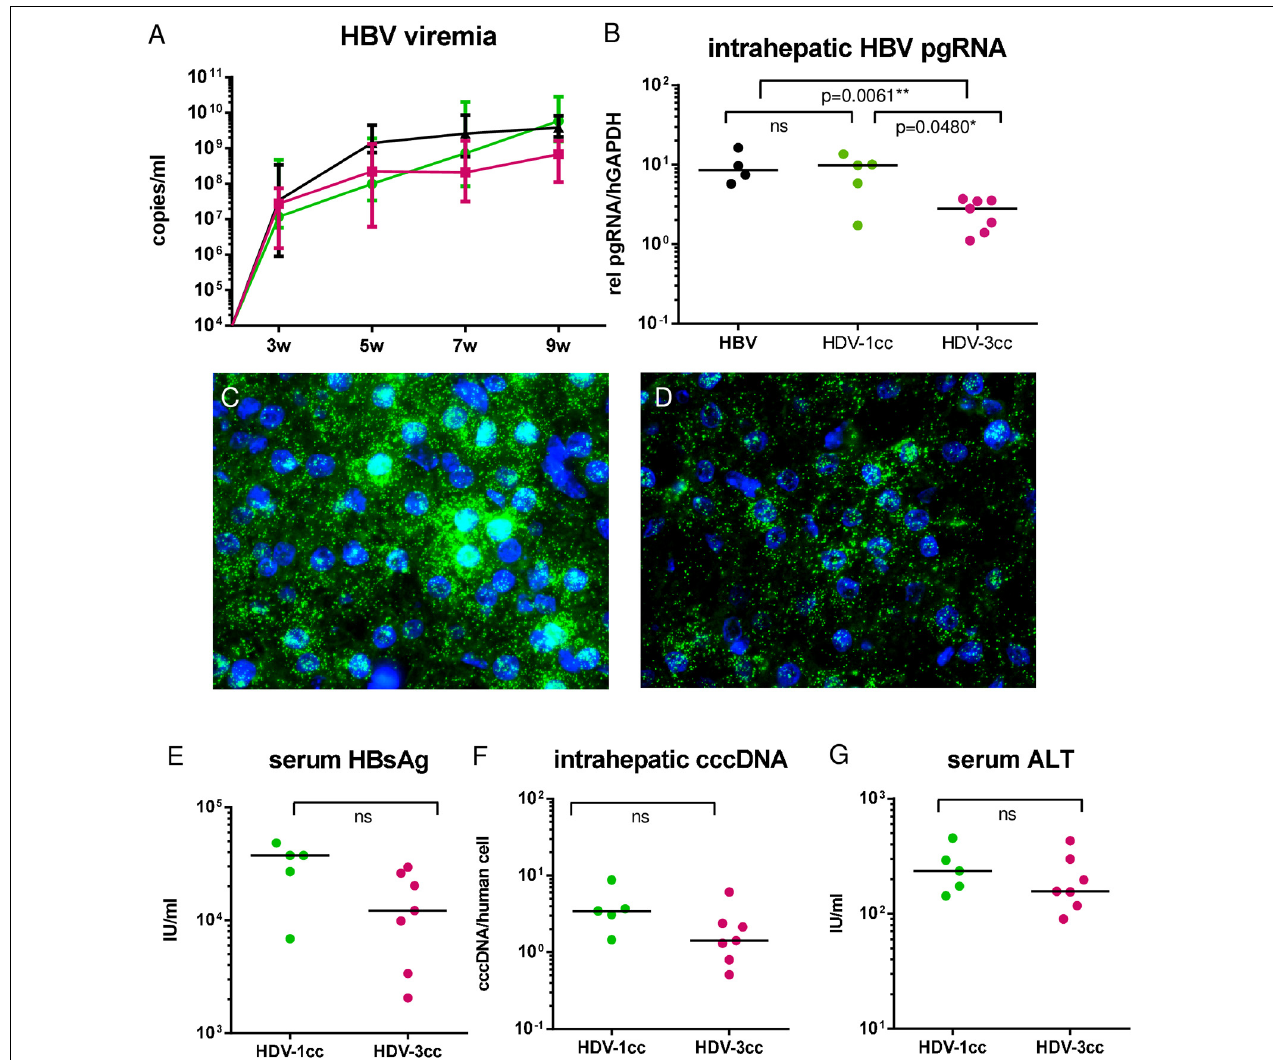
FIGURE 2 | HBV in mice co-infected with HBV and HDV-1cc or HDV-3cc. qRT-PCR measurements of serum HBV DNA (quantification with plasmid standard) (A) and liver pregenomic HBV RNA (normalized to housekeeping gene hGAPDH) (B) in HBV/HDV-1cc (green line or dots) and HBV/HDV-3cc (red line or dots) co-infected mice 9 weeks post infection compared to stable HBV mono-infected mice (black line or dots). Results are expressed as median ± range (A) , the bar shows median levels (B) . * p < 0.05, ** p < 0.01. RNA in situ hybridization (RNAScope) staining of pregenomic HBV RNA (green) in HBV/HDV-1cc (C) and HBV/HDV-3cc (D) co-infected mice at the end of the experiment. Nuclei are stained with dapi (blue). Serum HBsAg levels (E) , intrahepatic cccDNA levels (normalized to human beta globin) (F) and serum ALT levels (G) in HBV/HDV-1cc and HBV/HDV-3cc co-infected mice at the end of the experiment. The bar shows median levels (E–G)